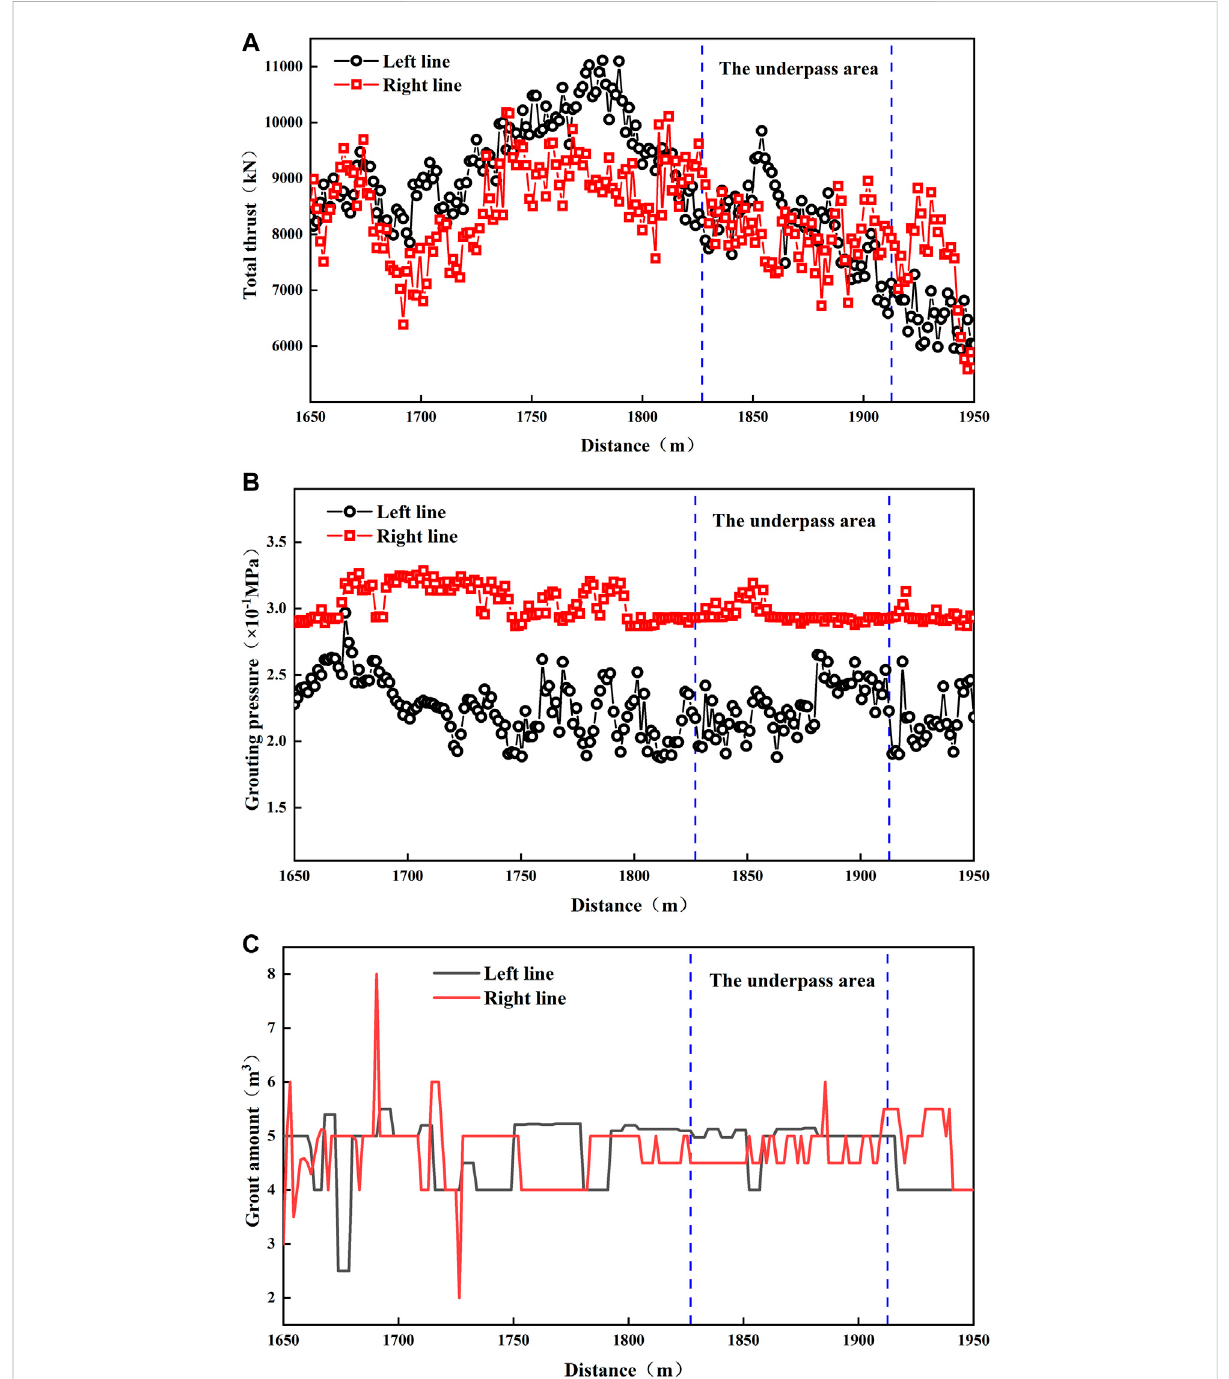
FIGURE 4 TBM tunneling parameters in underpass existing buildings: (A) total thrust; (B) grouting pressure; (C) grout